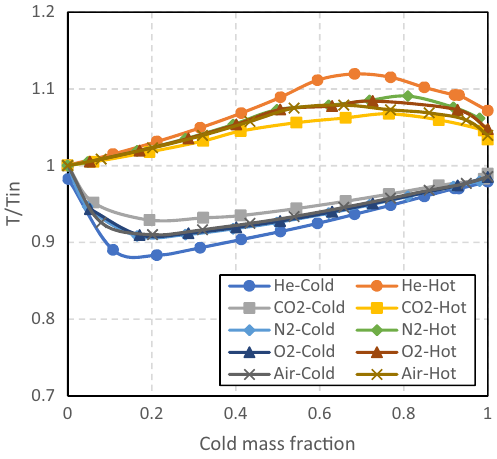
Fig. 6 Effect of cold mass fraction on the dimensionless total outlet temperature for different gases with 400 kPa at the inlet, 0 kPa at the cold outlet and variable pressure at the